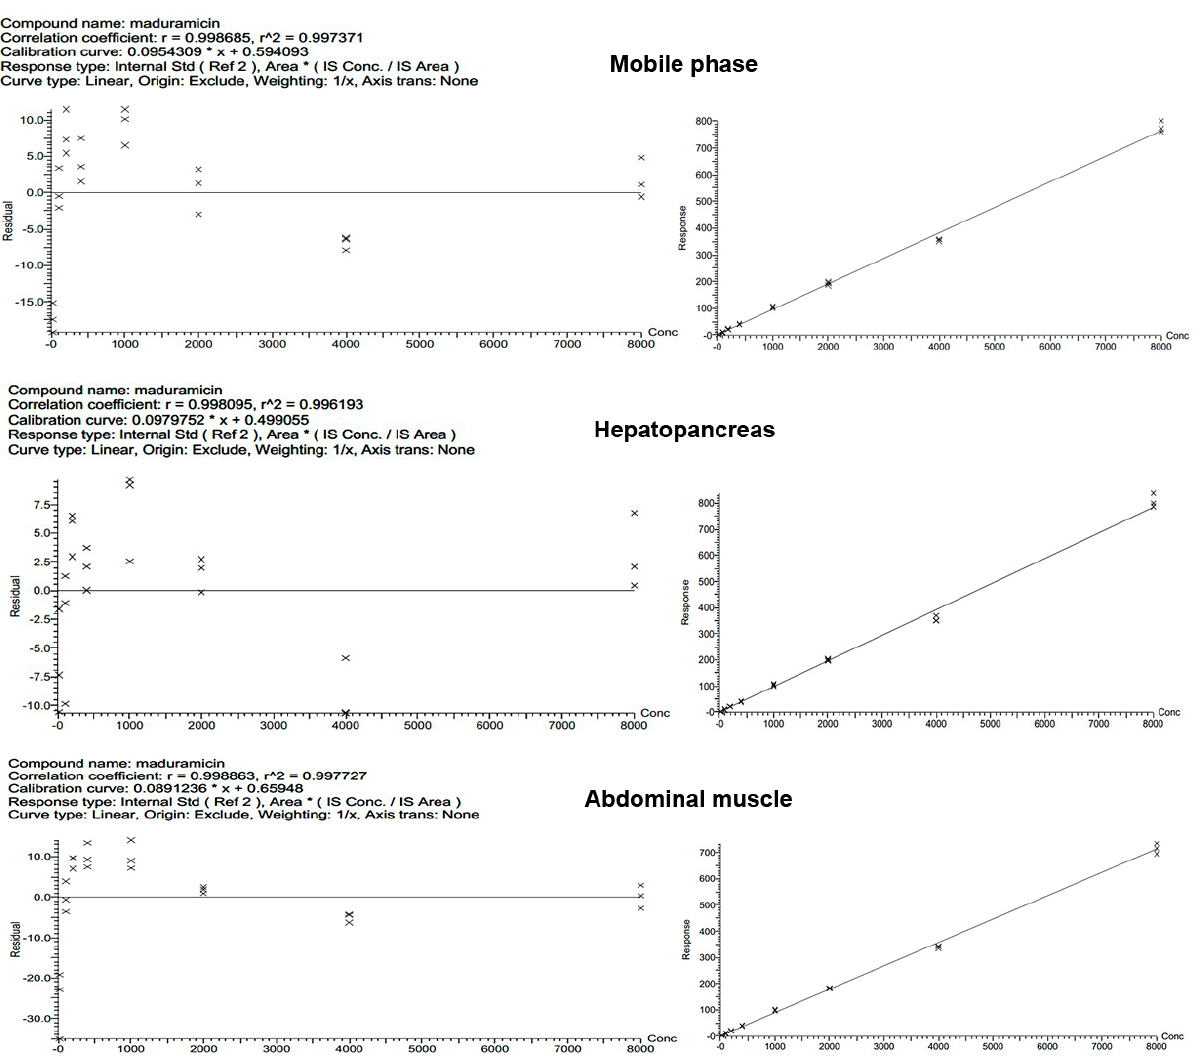
Figure 3. Matrix effects of crayfish hepatopancreas and muscle tissues on the analysis of maduramicin.